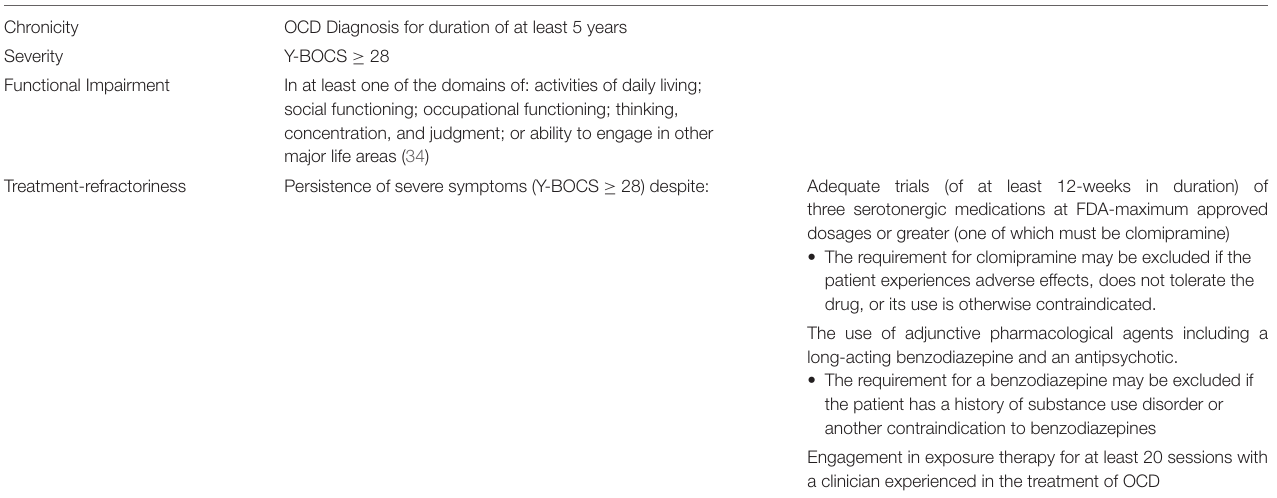
TABLE 1 | Medical necessity criteria for the use of DBS for refractory OCD*.